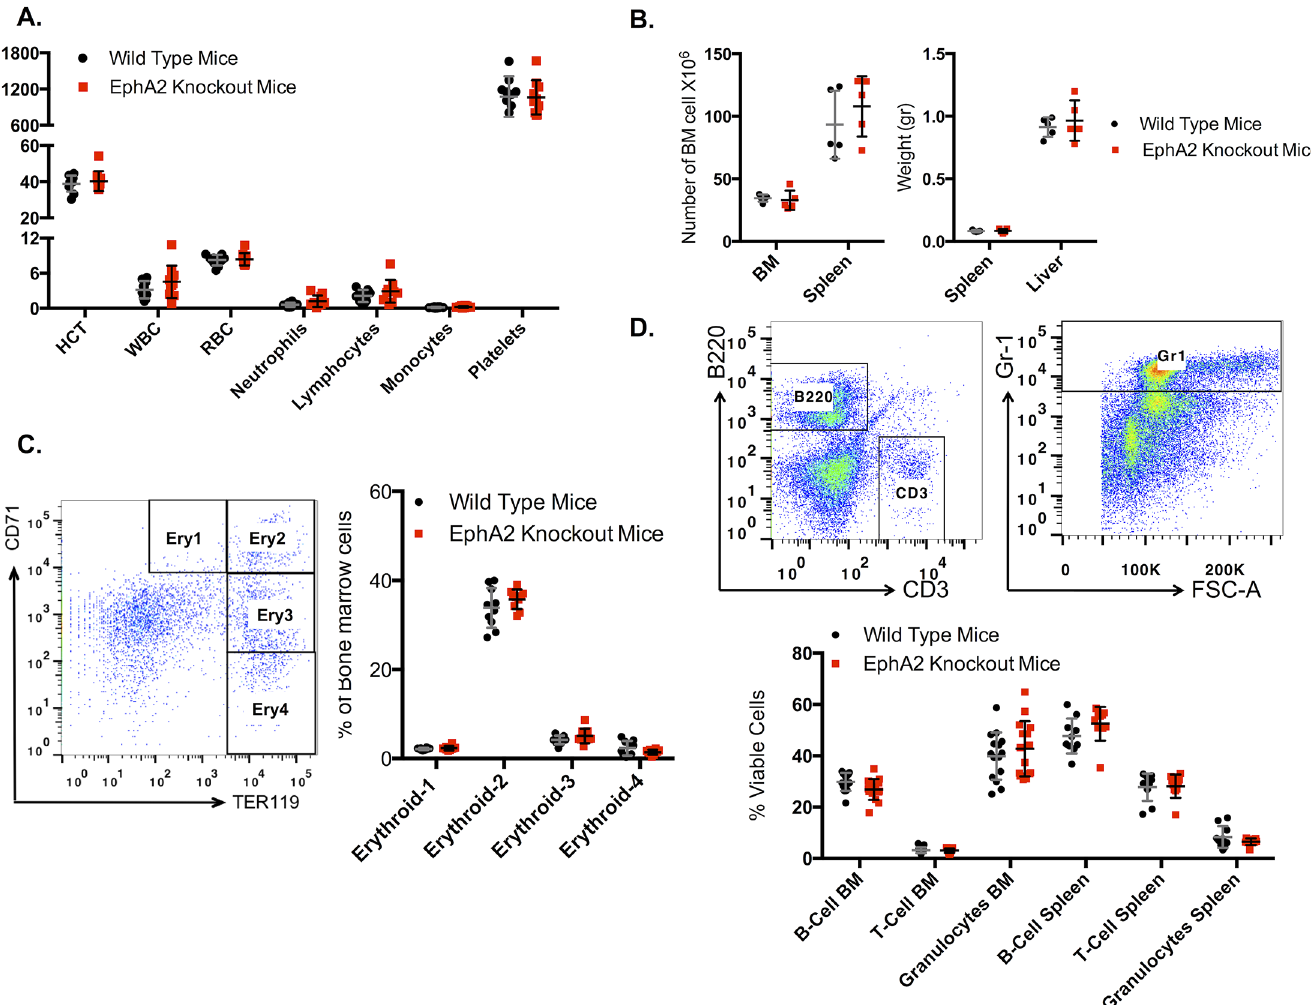
Fig 1. Immunophenotyping of EphA2 knockout mice compared to wild type littermates. ( A ) Full blood counts showed no significant differences in EphA2 knockout mice compared to wild type mice (n = 15, 3 independent experiments). ( B ) Number of nucleated bone marrow and spleen cells and spleen and liver weight of EphA2 knockout mice compared to the wild type littermates did not show any significant differences (n = 5). ( C ) Erythroid maturation analysis, erythroid-1 corresponding to pro-erythroblasts (CD71 high , Ter119 mid ), erythroid-2 corresponding to basophilic erythroblasts (CD71 high , Ter119 high ), erythroid-3 corresponding to late basophilic and polychromatophilic erythroblasts (CD71 mid , Ter119 high ) and erythroid-4 corresponding to late basophilic and polychromatophilic erythroblasts (CD71 low , Ter119 high ) in the bone marrow presented as percentage of viable bone marrow cells showed no differences in erythroid maturation in EphA2 knockout compared to wild type control cells (n = 15, 3 independent experiments). ( D ) B-lymphocytes (B220), T-lymphocytes (CD3) and Granulocytes (Gr-1) analysis showed no differences in B-lymphocytes, T-lymphocytes or granulocytes population in bone marrow, spleen and blood of the EphA2 knockout mice compared to the wild type control mice (n = 15, 3 independent experiments). The data represent the mean ± SEM (standard error of the mean). Unpaired t test was performed for statistical analyses (n) represent the number mice used in each experiment. An unpaired t test was performed for statistical